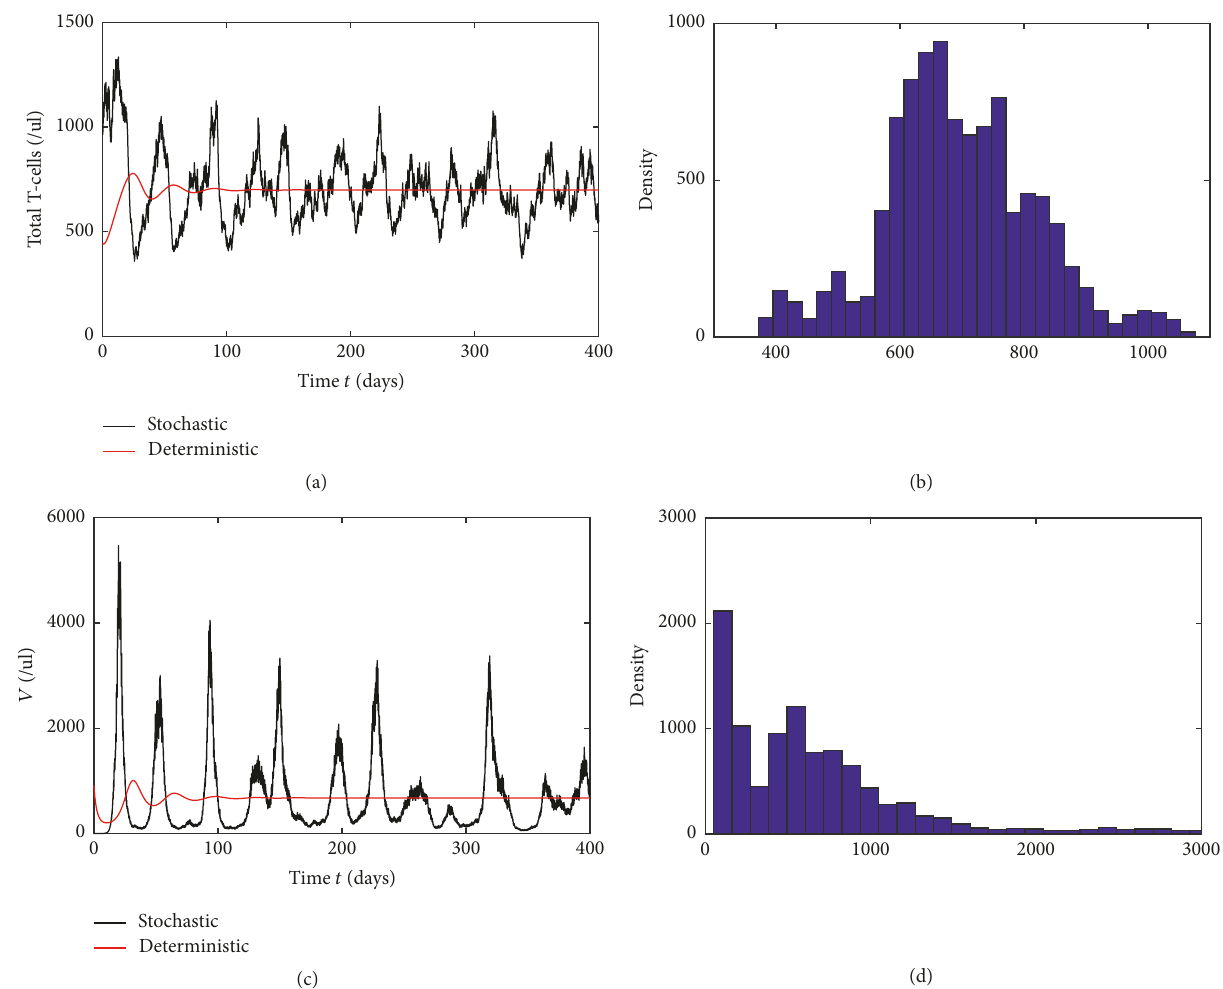
Figure 1: The solution of stochastic model (5) and its histogram with white noises 𝜎 1 = 𝜎 2 = 𝜎 3 = 0.08 and 𝜎 4 = 0.4 . The black lines are the solutions of total T-cells and virus populations of stochastic model (5), and the red lines are the solutions of their deterministic model,